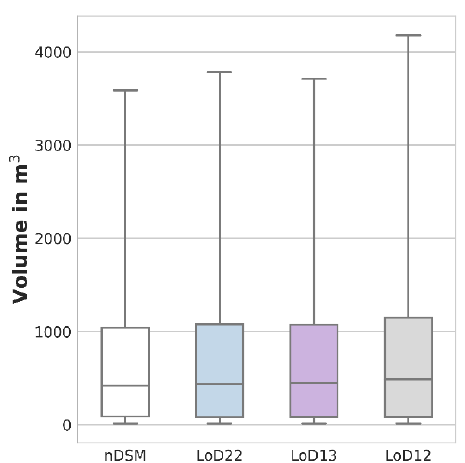
Figure 4 . Distribution of gross volume of buildings in each model. Top and bottom whiskers correspond to the 95 th and 5 th percentile,